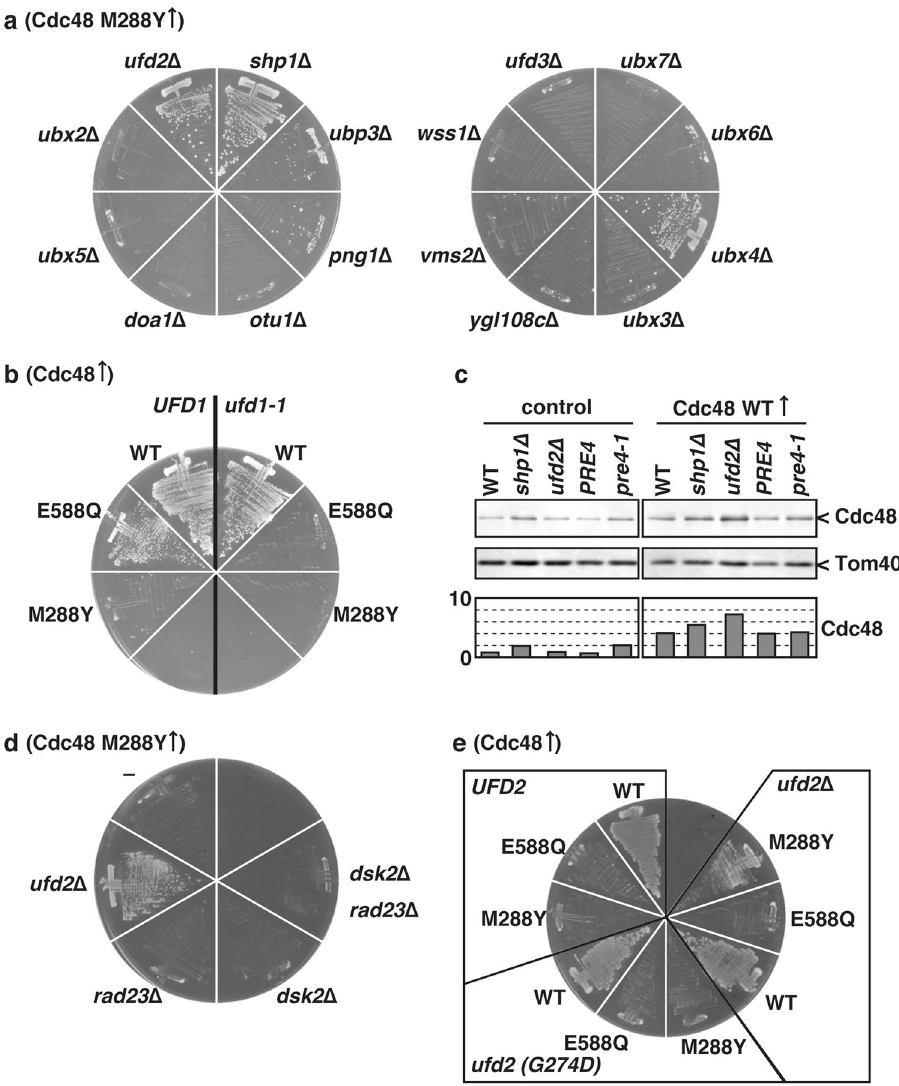
Figure 2. UFD2 and SHP1 were predominantly involved in expressing lethal phenotype by the M288Y mutation of Cdc48. ( a ) Cells lacking the indicated endogenous gene were transformed with a plasmid expressing the Cdc48 M288Y mutant under the control of the CUP1 promoter. The transformants were grown on media supplemented with 10 µ M CuCl 2 at 30 °C for 2 days. ( b ) ufd1-1 cells and the corresponding wild- type UFD1 cells were transformed with a CUP1 promoter-regulated plasmid expressing wild-type Cdc48 (WT) and mutant Cdc48 with the replacement of E588Q and M288Y. The transformants were grown on media supplemented with 10 µ M CuCl 2 at 30 °C for 2 days. ( c ) Whole cell lysates were prepared from cells with a plasmid expressing wild-type Cdc48 (right panel) and no proteins (left panel) grown at 10 µ M CuCl 2 as shown previously 48 . Equal amounts of cell extracts were analyzed by SDS-PAGE followed by immunoblotting using anti-Cdc48 and anti-Tom40 antibodies. The graphs show relative amounts of Cdc48 using Tom40 as a control. ( d ) Cells lacking the indicated endogenous genes were transformed with the CUP1 promoter-regulated plasmid expressing the Cdc48 M288Y mutant. The transformants were grown on media supplemented with 100 µ M CuCl 2 at 30 °C for 2 days. ( e ) ufd2 ∆ cells were transformed with a plasmid expressing wild-type Ufd2, Ufd2 with a G274D mutation, no proteins. Those cells were transformed with the CUP1 promoter-regulated plasmid expressing wild-type Cdc48 (WT) and mutant Cdc48 with the replacement of E588Q and M288Y. The transformants were grown on media supplemented with 100 µ M CuCl 2 at 30 °C for 2